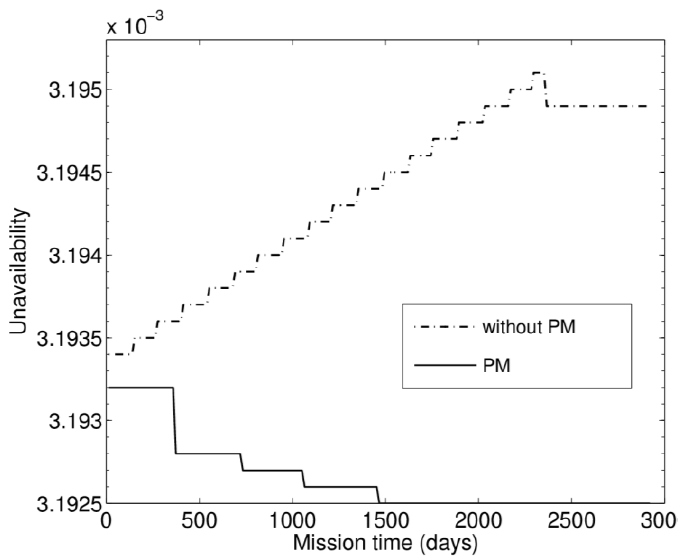
Figure 4. Effect of PM on the unavailability evolution of system Version